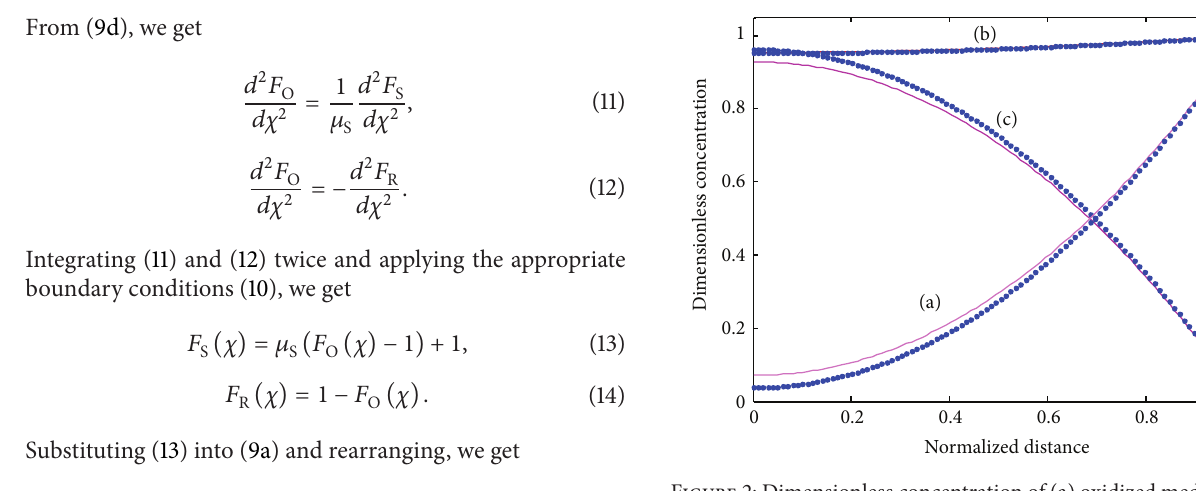
Figure 2: Dimensionless concentration of (a) oxidized mediator 𝐹 O (17), (b) substrate 𝐹 (13), and (c) reduced mediator 𝐹 (14) versus S R = 0.5 , 𝐵 = 0.0052 , 𝜇 = 0.05 , and normalized distance 𝜒 for 𝐵 O S S = 400 . Solid lines represent the analytical solution whereas the 𝜙 2 O dotted lines represent the numerical